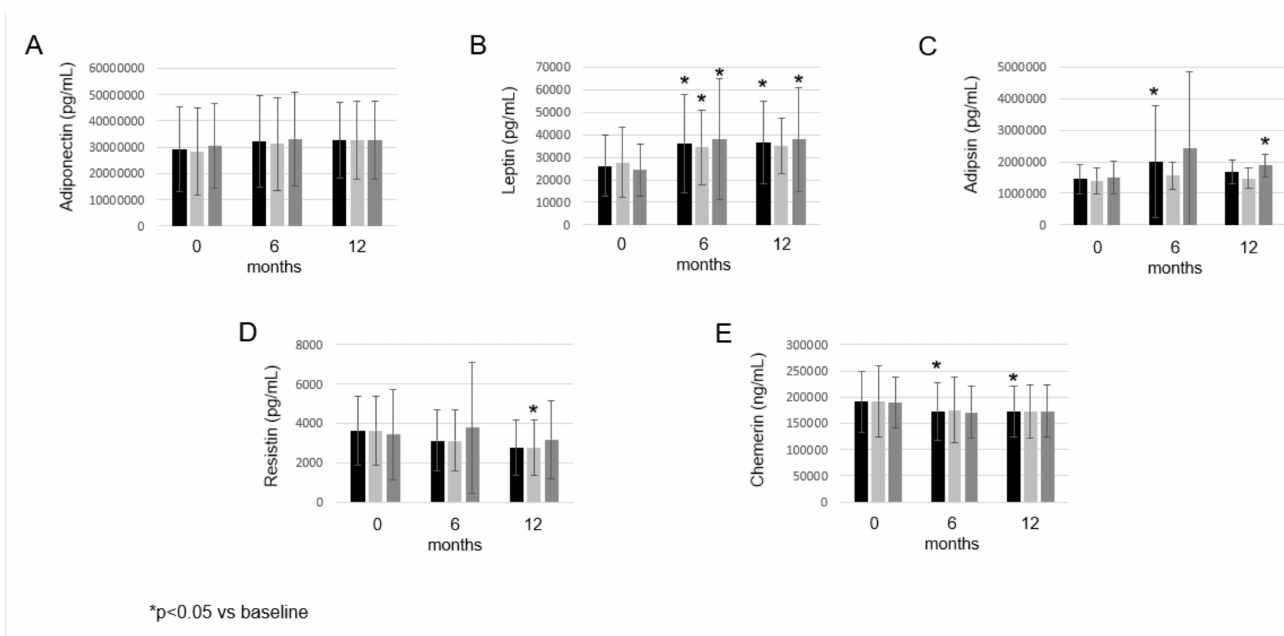
Figure 2. Effects of one-year tofacitinib therapy on adiponectin ( A ), leptin ( B ), adipsin ( C ), resistin ( D ) and chemerin ( E ) levels in the entire RA whole cohort, 5 mg bid and 10 mg bid treatment arm, respectively, at baseline, and 6 and 12 months of treatment. Asterisks indicate significant changes ( p < 0.05).